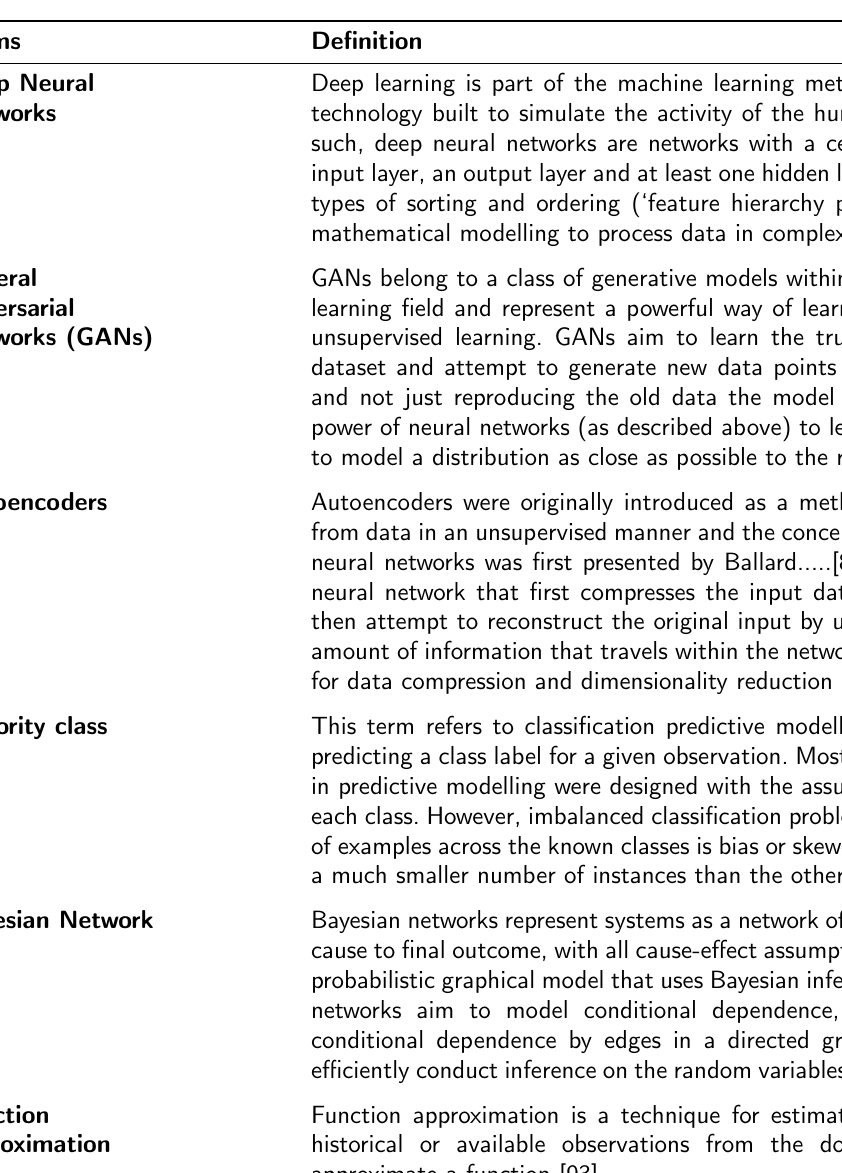
Supplementary Table 2: Glossary of synthetic data generation